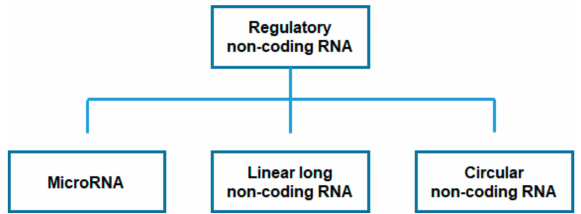
Figure 1. Scheme presenting the selected regulatory non-coding